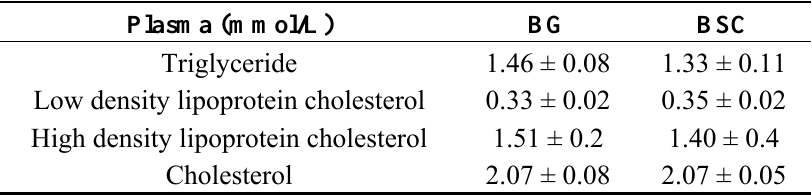
Table 3. Concentrations of plasma lipids.